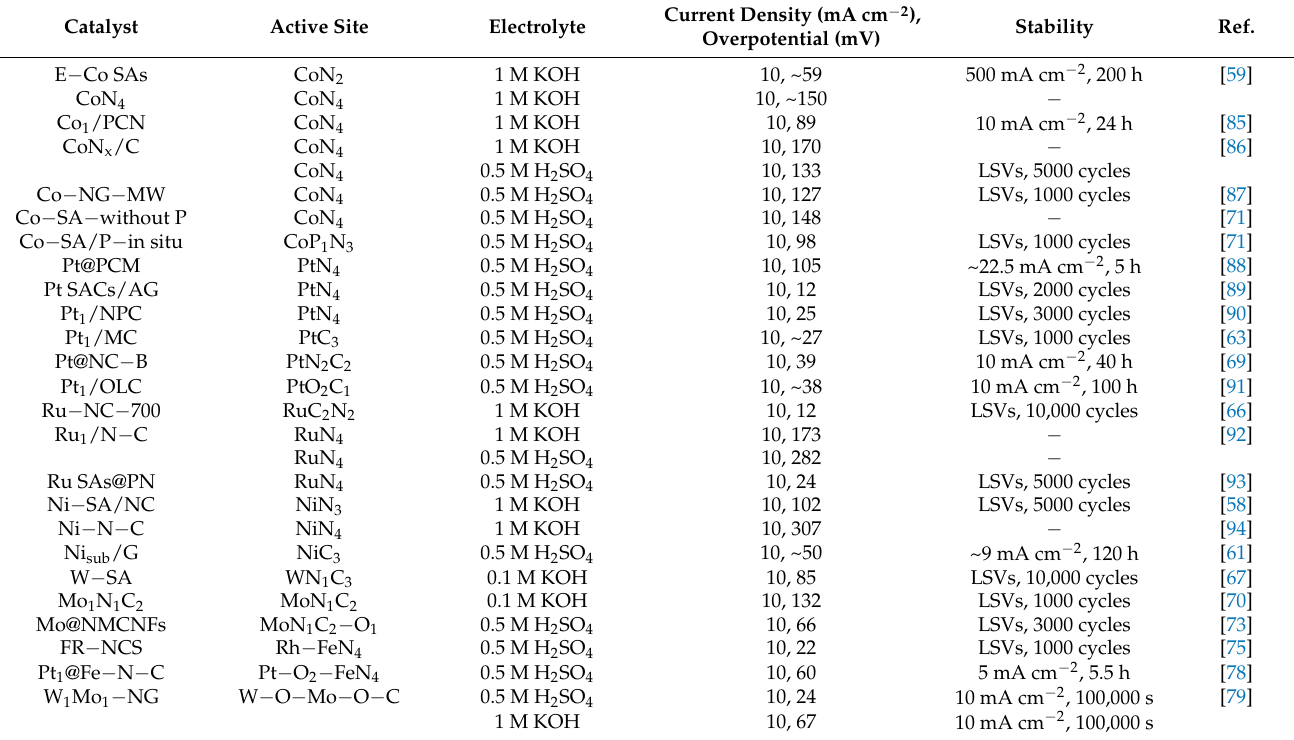
Table 1. The comparison of the HER performance of the carbon − based SACs with the different active